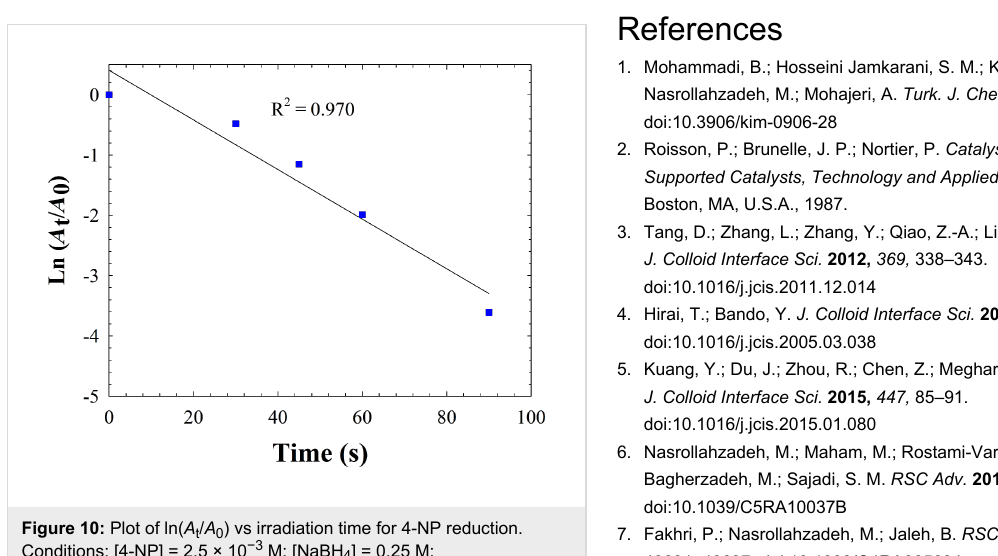
42]. The enhanced reactivity of the Cu NPs/bentonite is related to the dispersion of Cu NPs particles in the support, which provides more accessible reactive sites for reduction of 4-NP.